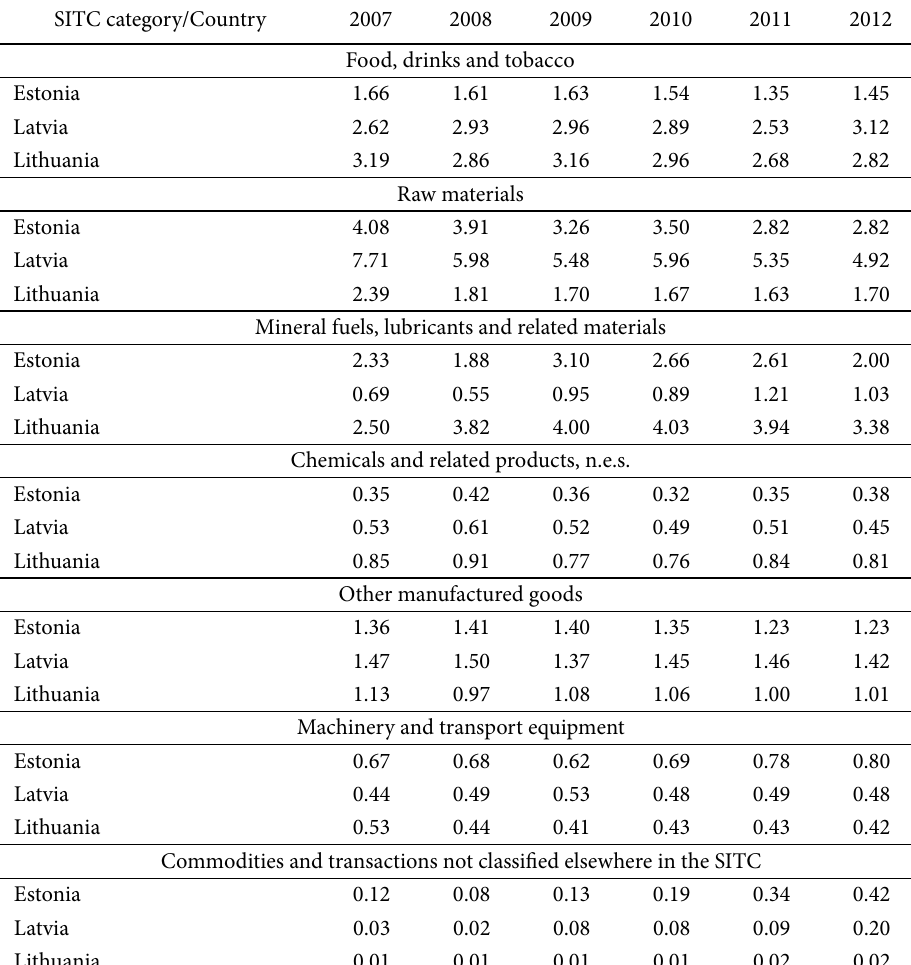
* In the table, calculated RCa values include the year 2007 with a view to comparison RCa values with the year